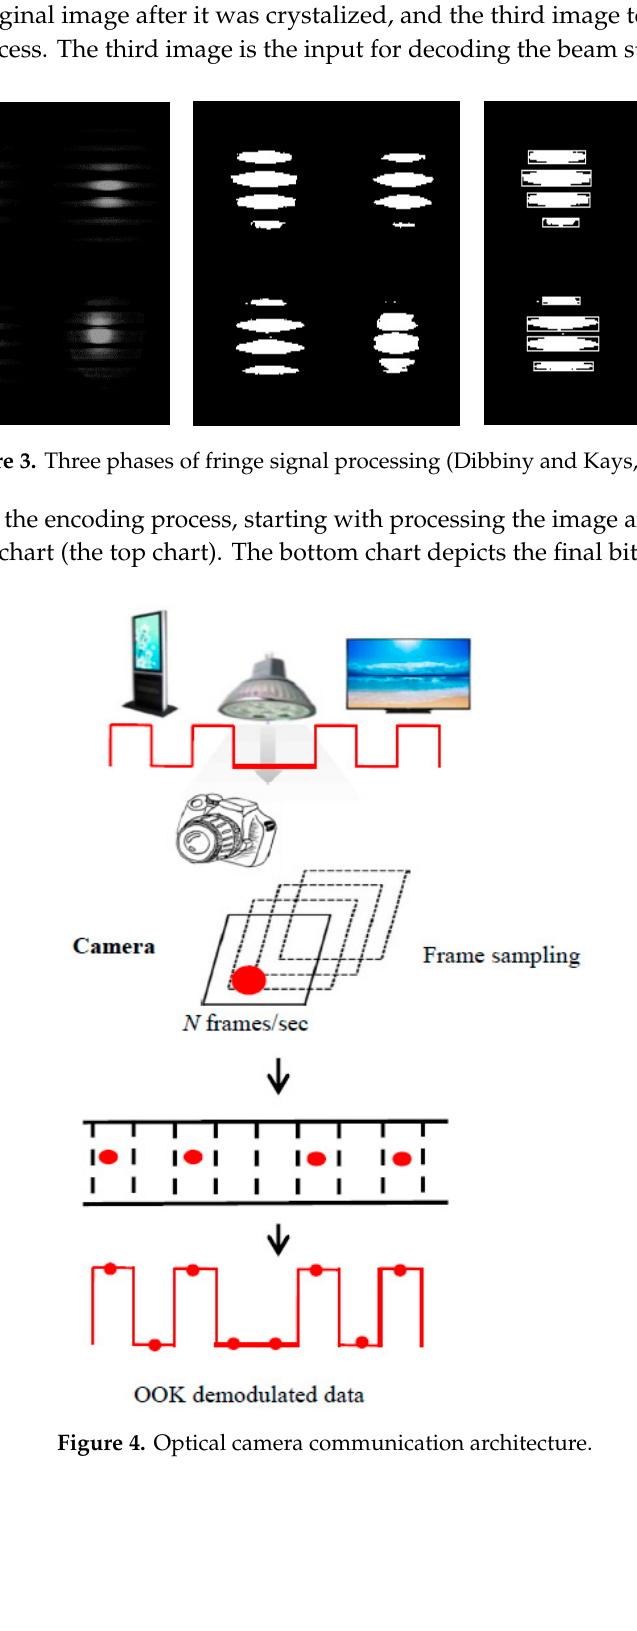
Figure 4. Optical camera communication architecture.